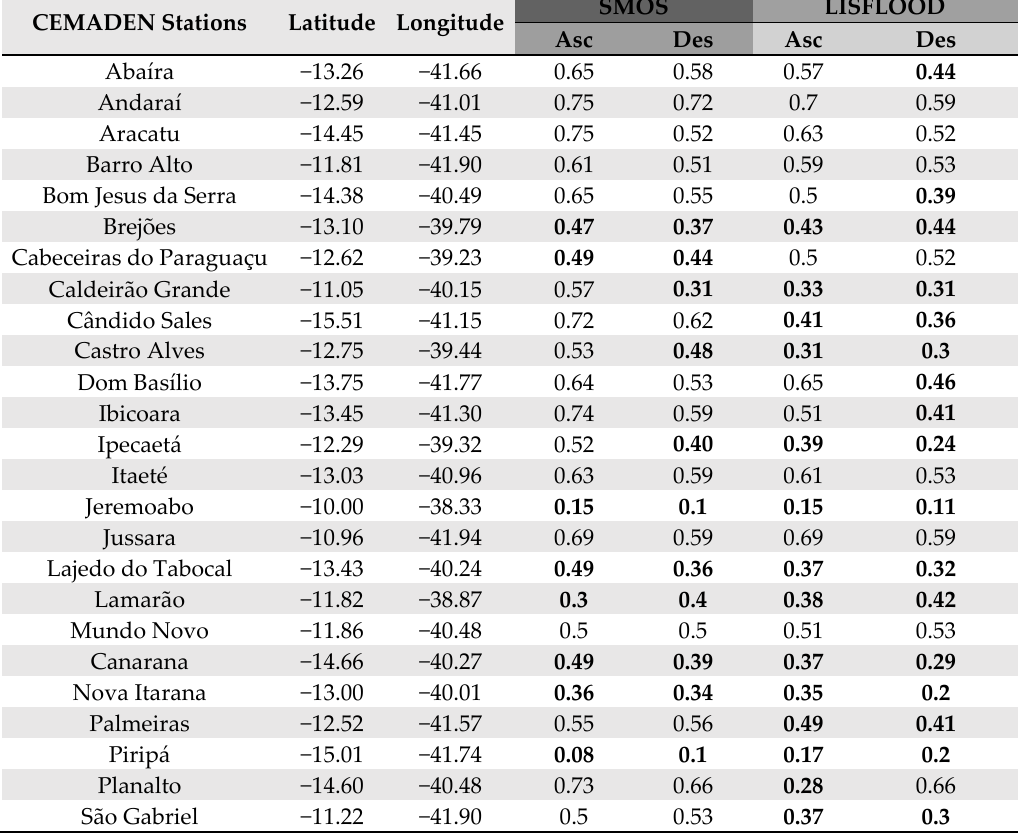
Table 1. Correlation between CEMADEM stations SM at 10 cm and SMOS L4 SM and LISFLOOD model at the ascending or descending satellite passes. In boldface: stations with correlation smaller than 0.5.